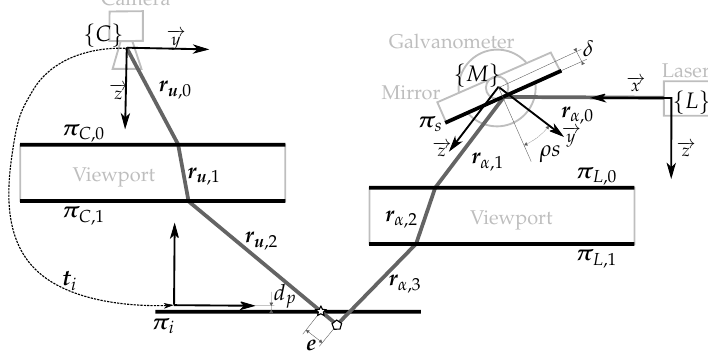
Figure 8. Illustration of the laser viewport calibration error. The star represents the point computed by intersecting the camera ray with the object while the pentagon represents the point computed intersecting the camera ray with the laser ray. Note that the laser ray r α ,3 and the camera ray r u ,2 do not intersect in the projection plane π i because the laser viewport is not estimated